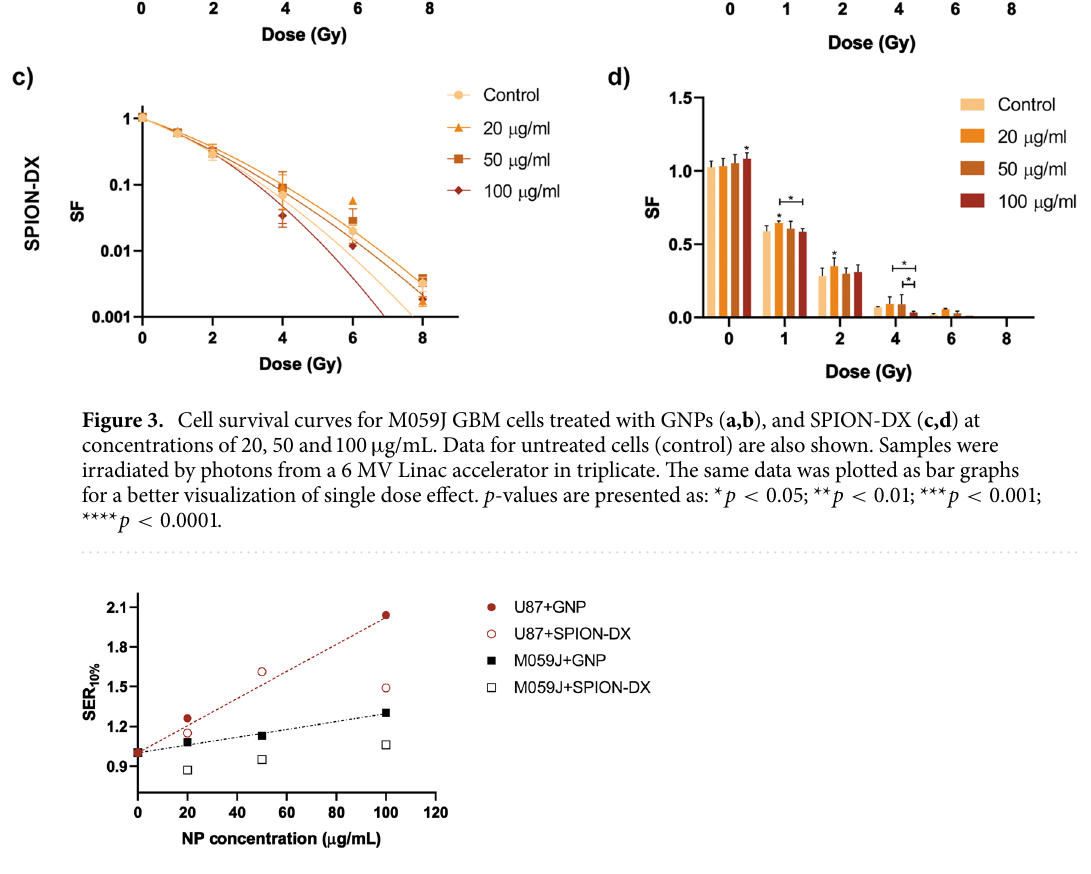
Figure 4. SER 10% as a function of treatment concentration for U87 and M059J cells exposed to GNPs (circles) and SPION-DX (squares). The lines are linear fittings to the GNP experimental